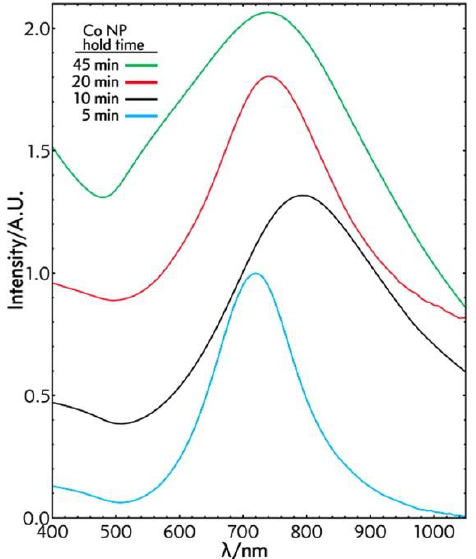
Figure 13. UV-Vis absorption spectral study of hollow gold nanoshell solution taken after NaBH 4 addition — 45 min (green), 20 min (red), 10 min (black), and 5 min (blue). Reprinted with permission from Reference [70]. Copyright (2014) American Chemical Society.